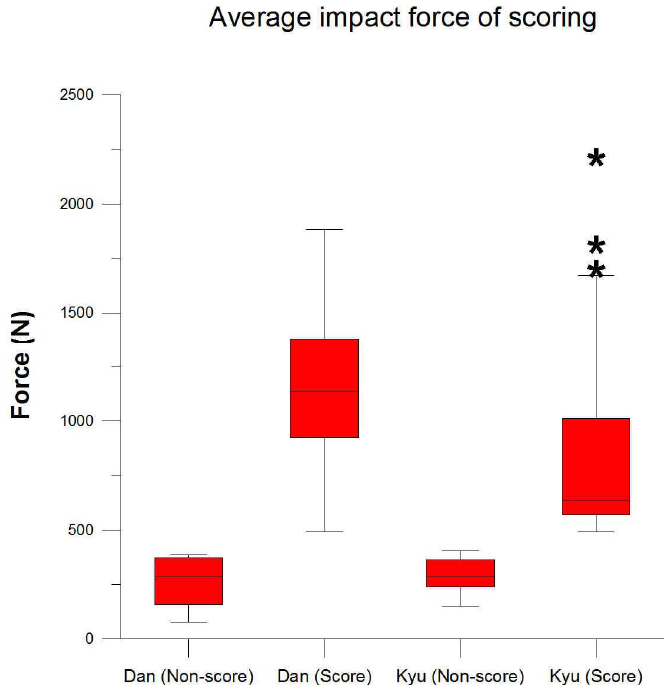
Figure 5. The box-whisker plots of average of impact force scoring and non-scoring of force (N) in Dan grade and Kyu grade (* =